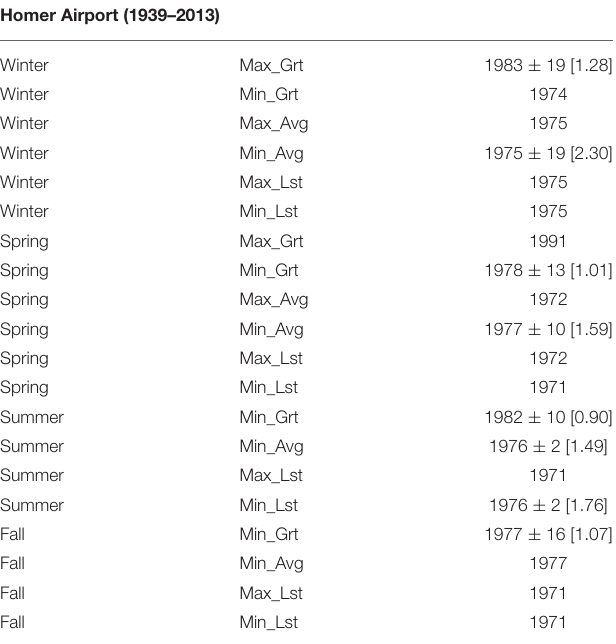
TABLE 4D | Change-points in mean for station HA of Alaska with: PELT change-point estimate ± width of approximate 95% confidence interval